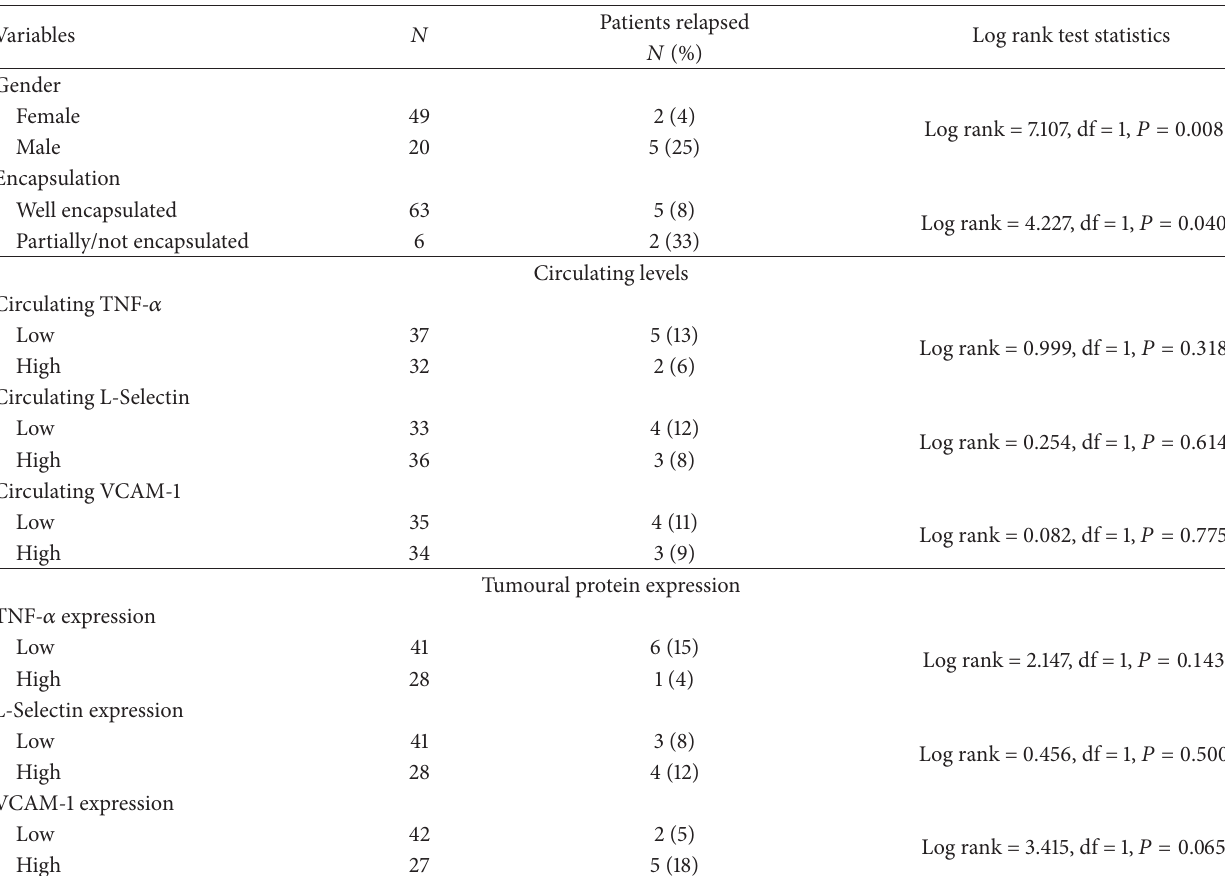
Table 7: Univariate survival analysis for DFS in PTC patients ( 𝑁 = 69